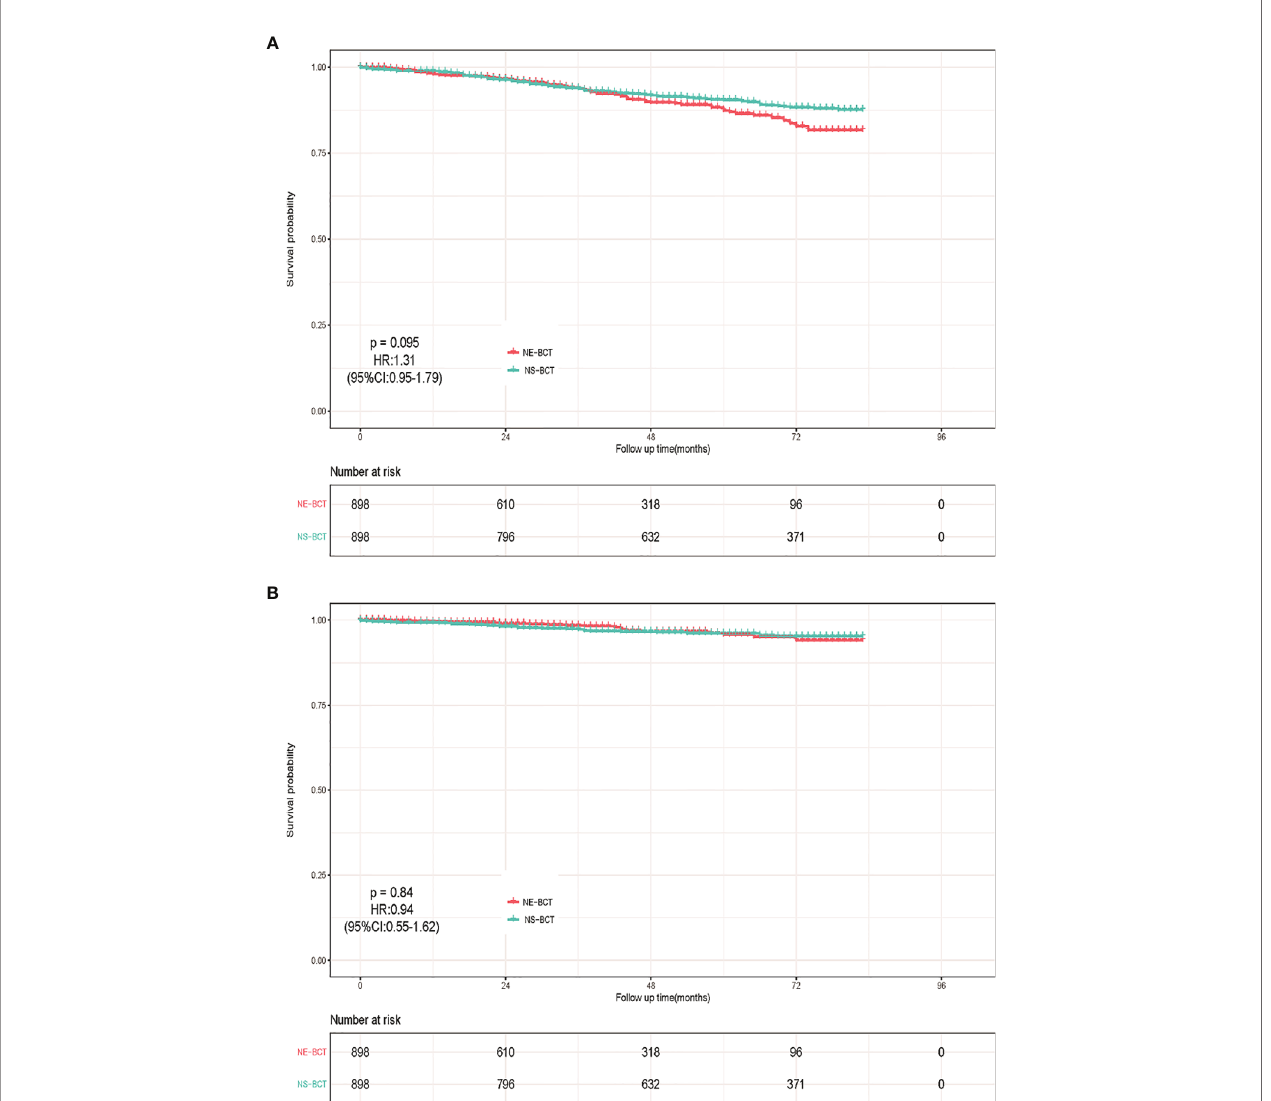
FIGURE 5 | Kaplan – Meier survival analysis for NE-BCT and NS-BCT female breast cancer patients between 2010 and 2015. (A) Overall survival curves in the NE- BCT and NS-BCT groups. (B) Breast-cancer-speci fi c survival curves in the NE-BCT and NS-BCT